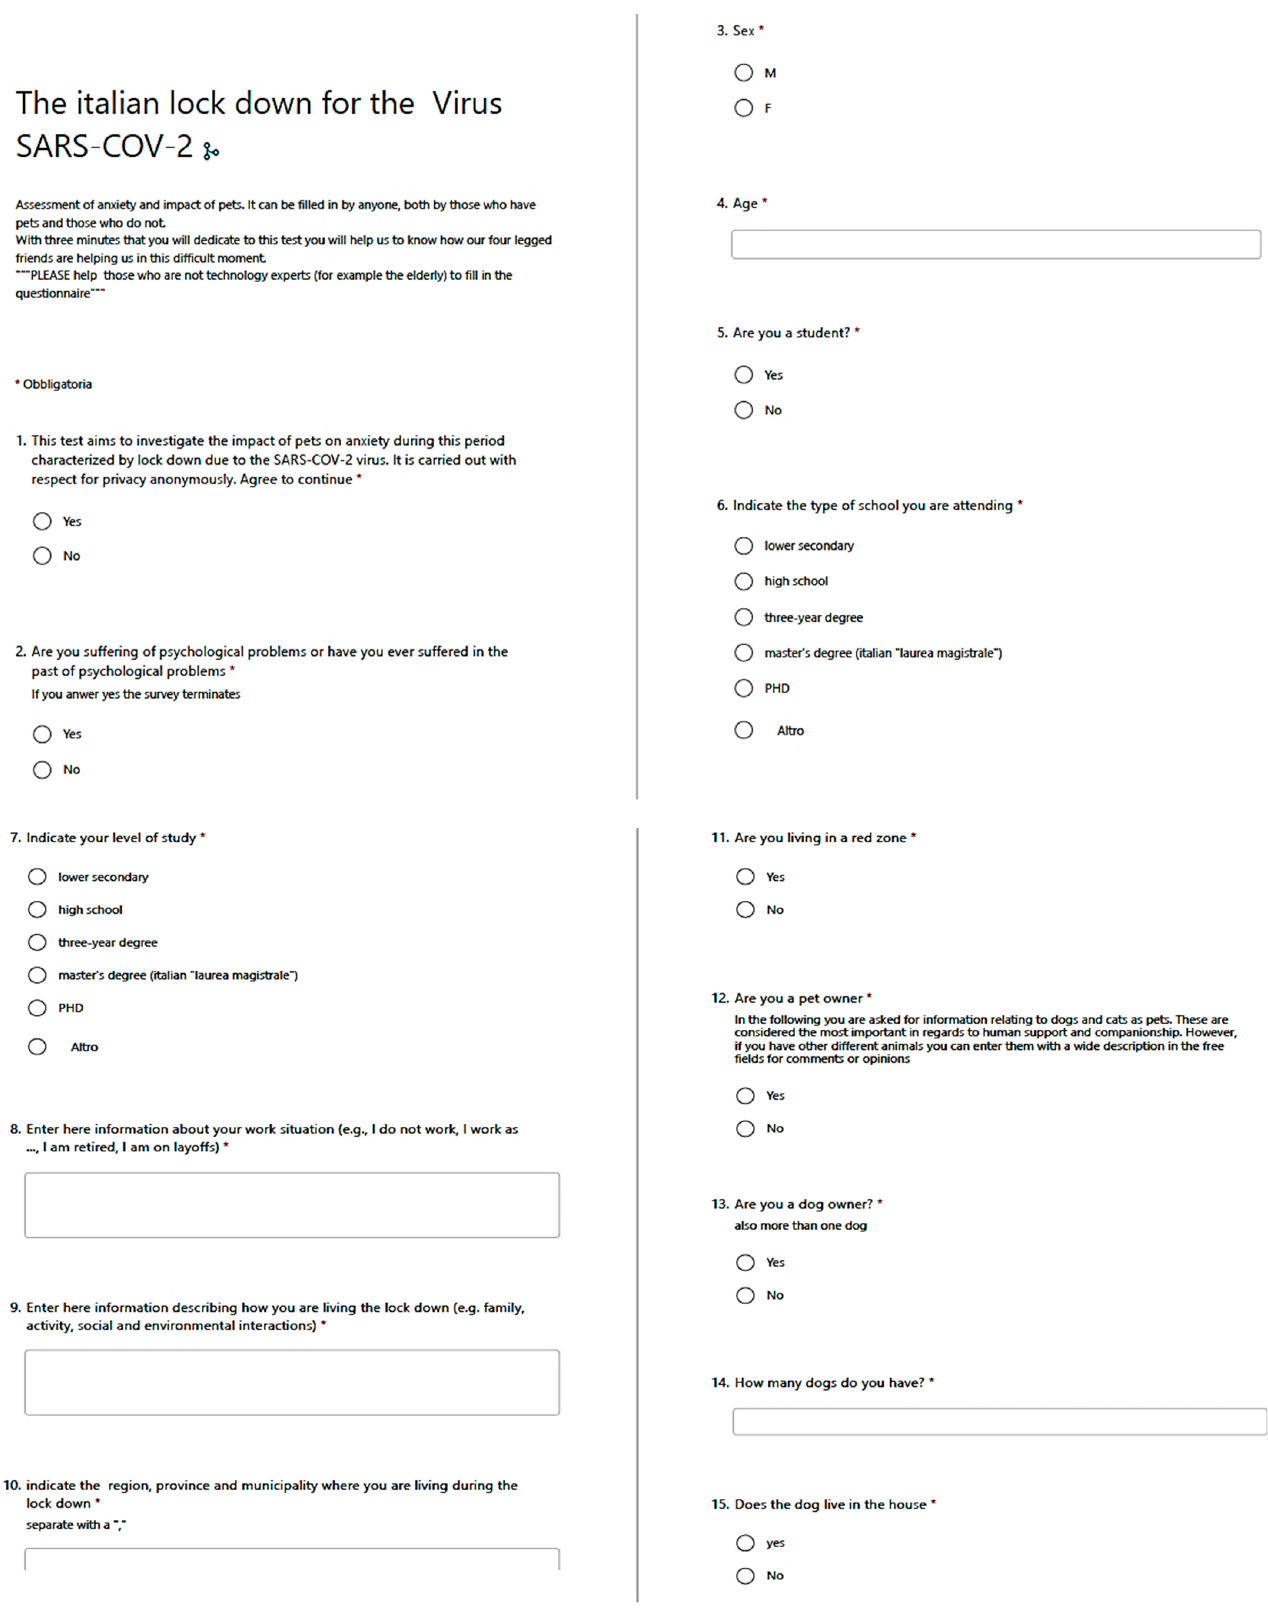
Figure A2. Tool Section dedicated to the collection of the demographic data. “*” indicates mandatory questions.